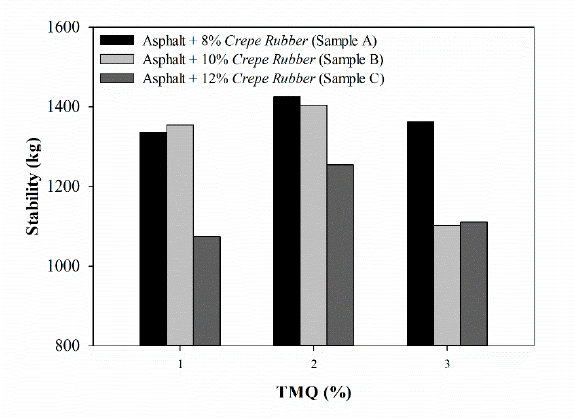
Figure 5. Marshall stability.